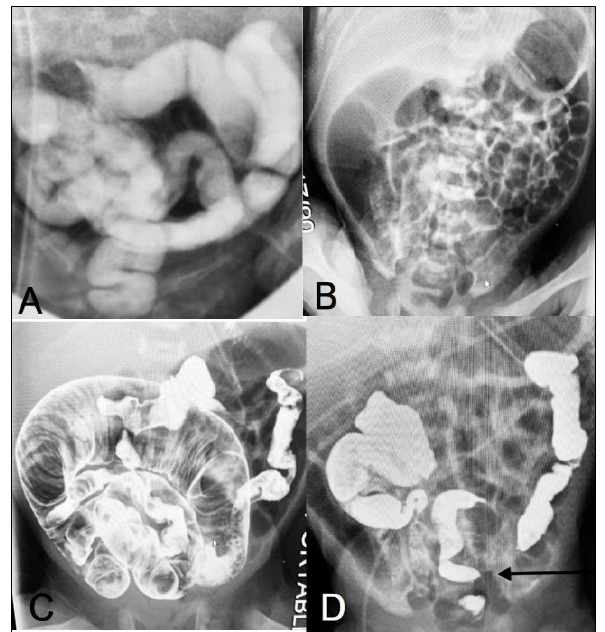
Figure 1: A) Contrast outlines the colon. B) X-ray abdomen showing dilated small bowel loops. C) Contrast outlines the dilated small bowel loops. D) Ultimately the contrast evac- uates to the rectum (Arrow) In these micro-preemies, intestinal perforation is not "spontaneous"; rather, it is caused by intra-luminal obstruction of the terminal ileum. The more proximal bowel dilates; and if the muscular layer is weak (in- adequately developed), aneurysmal dilatation may occur and ultimately a perforation. During enteros- tomy closure, I have searched for the